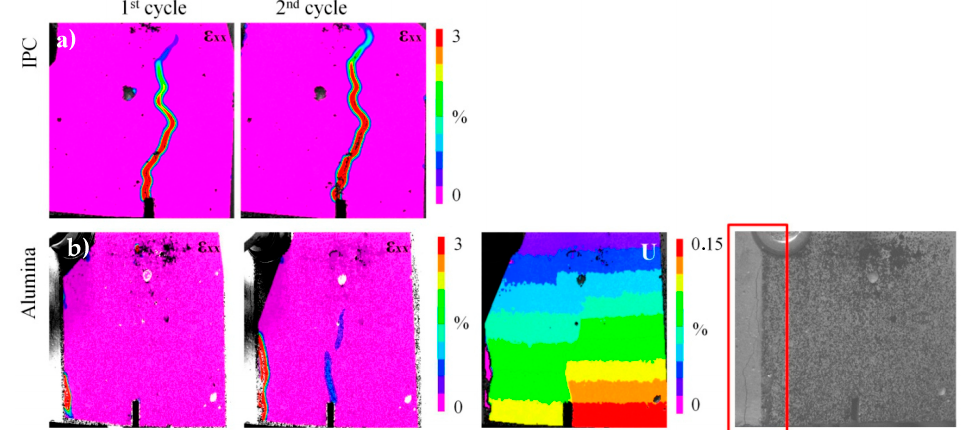
Figure 5. ( a ) DIC strain ( ε xx ) maps at the end of loading and reloading cycle (cementitious healing network case); and ( b ) DIC strain maps ( ε xx ) at the middle region of the beam (ceramic healing network). DIC deformation (U) map at the end of the reloading cycle. The speckle pattern is not wide enough to visualize the crack that forms at the left side of the beam. The crack is shown in the last image of this series, captured at the end of the reloading cycle.